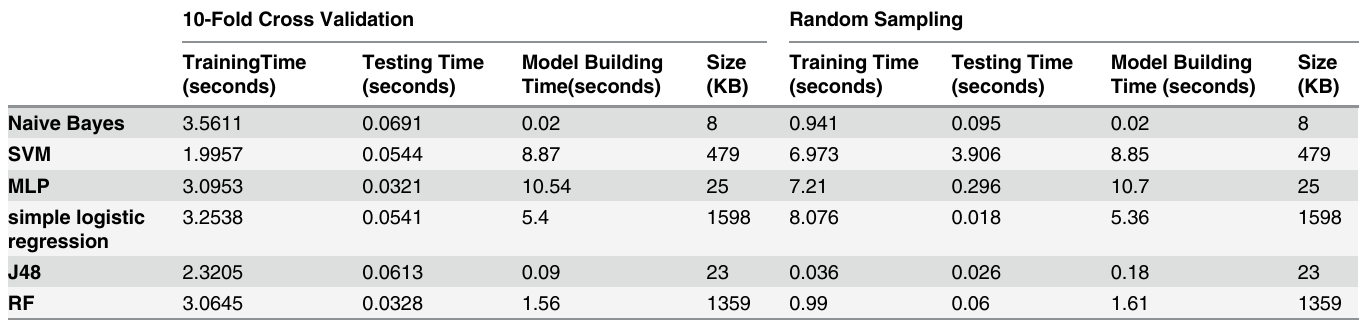
Table 7. Time and Size Comparison. 10-Fold Cross